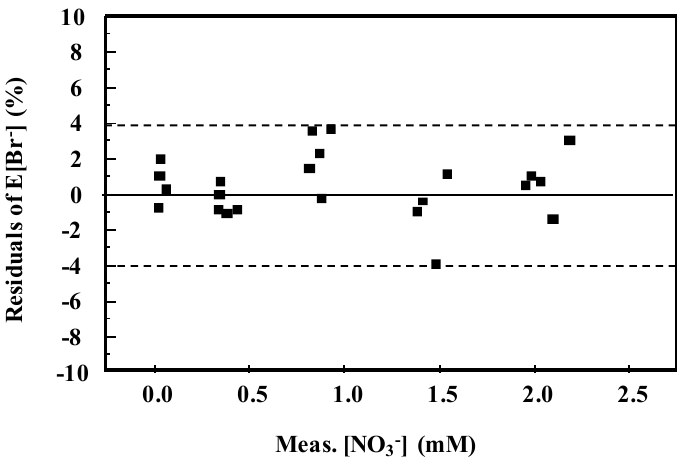
Figure 5. Residuals of E[Br − ] (difference between experimental points and fitted values) vs. Meas.[NO 3 − ].